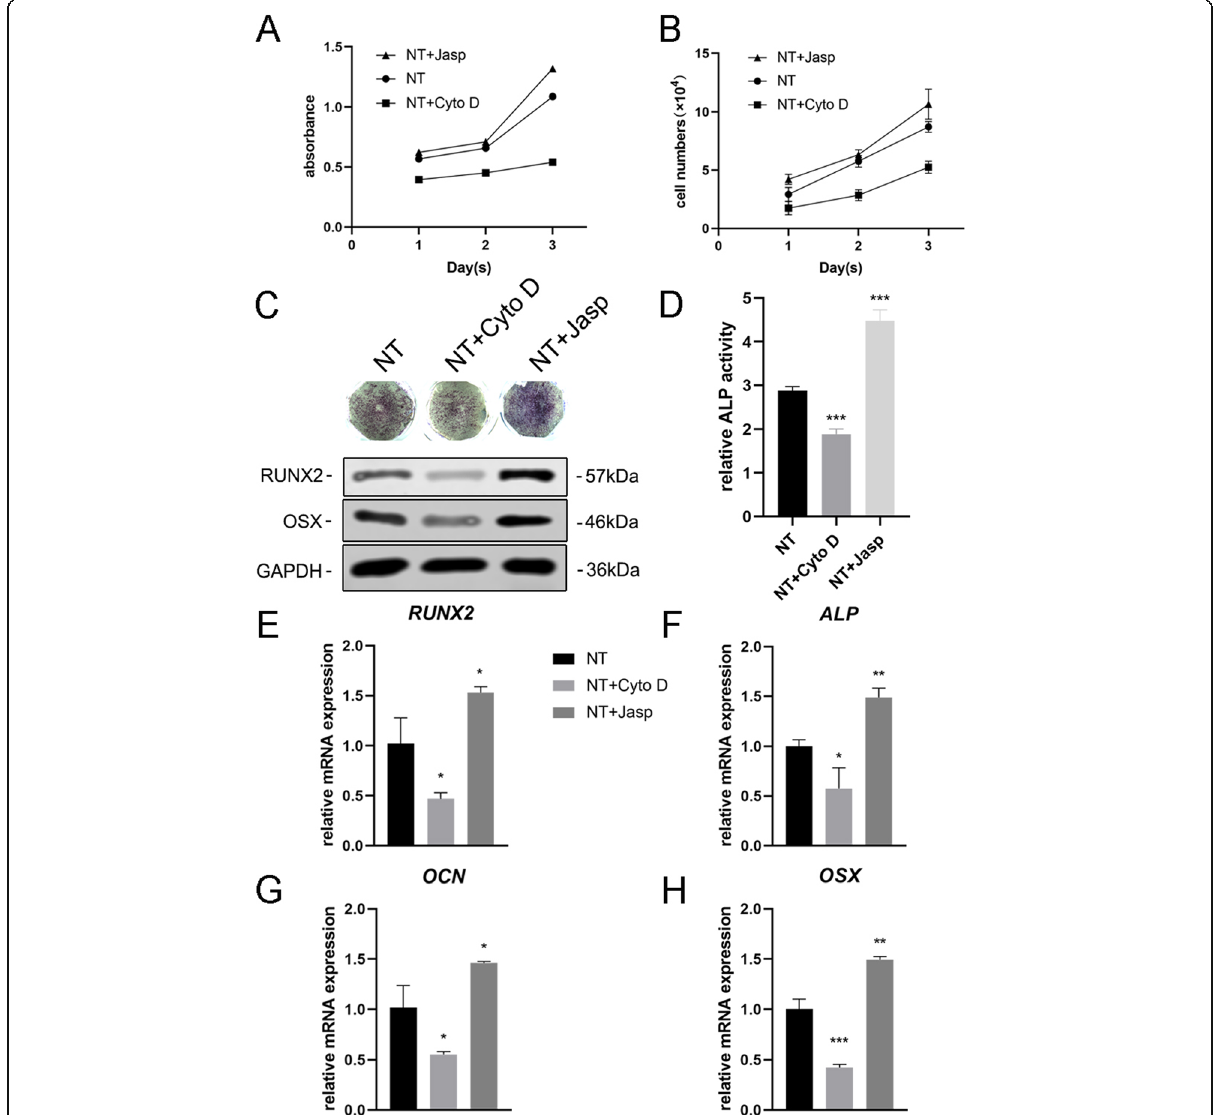
Fig. 4 F-actin assembly regulated the expression of osteogenic genes in BMSCs. a , b Cell proliferation after Cyto D and Jasp treatment was determined using the CCK-8 assay or automated cell counter at days 1, 2, and 3. c , d ALP staining and ALP activity analysis was performed to evaluate the expression of ALP in MSCs after drug treatment for 3 days. Staining area was analyzed using ImageJ. c , e – h Western blotting and qRT-PCR were used to compare the changes of osteogenesis-related markers in the NT+ Cyto D group and the NT+ Jasp group with those in the control group (without drug treatment). NT the nanotubes group. Data represent the mean ± SD of three samples. * P < 0.05, ** P < 0.01, and *** P <